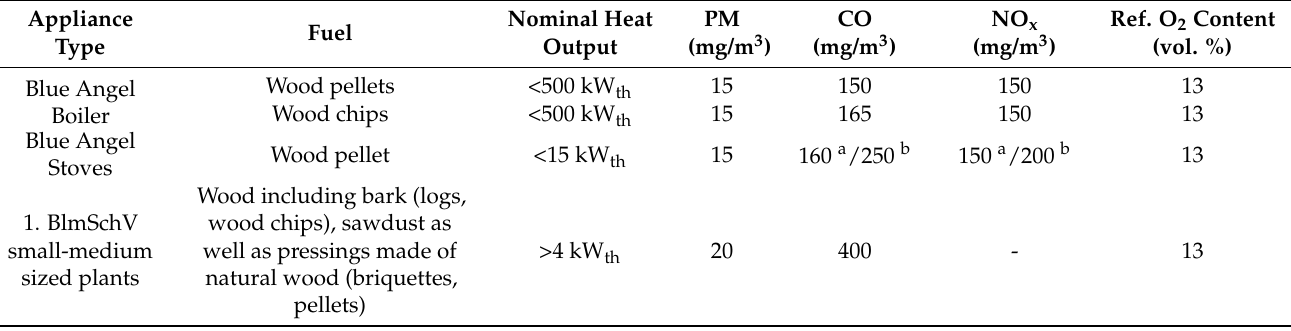
Table 5. Overview of the emission limits in the official regulations